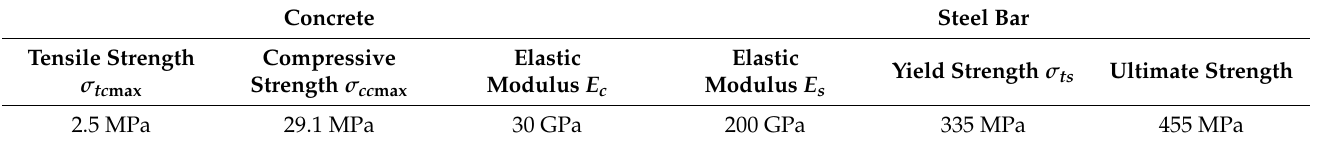
Figure 4. Reinforcement diagram of RC arch (mm). Table 1. Mechanical properties of concrete and steel bars.